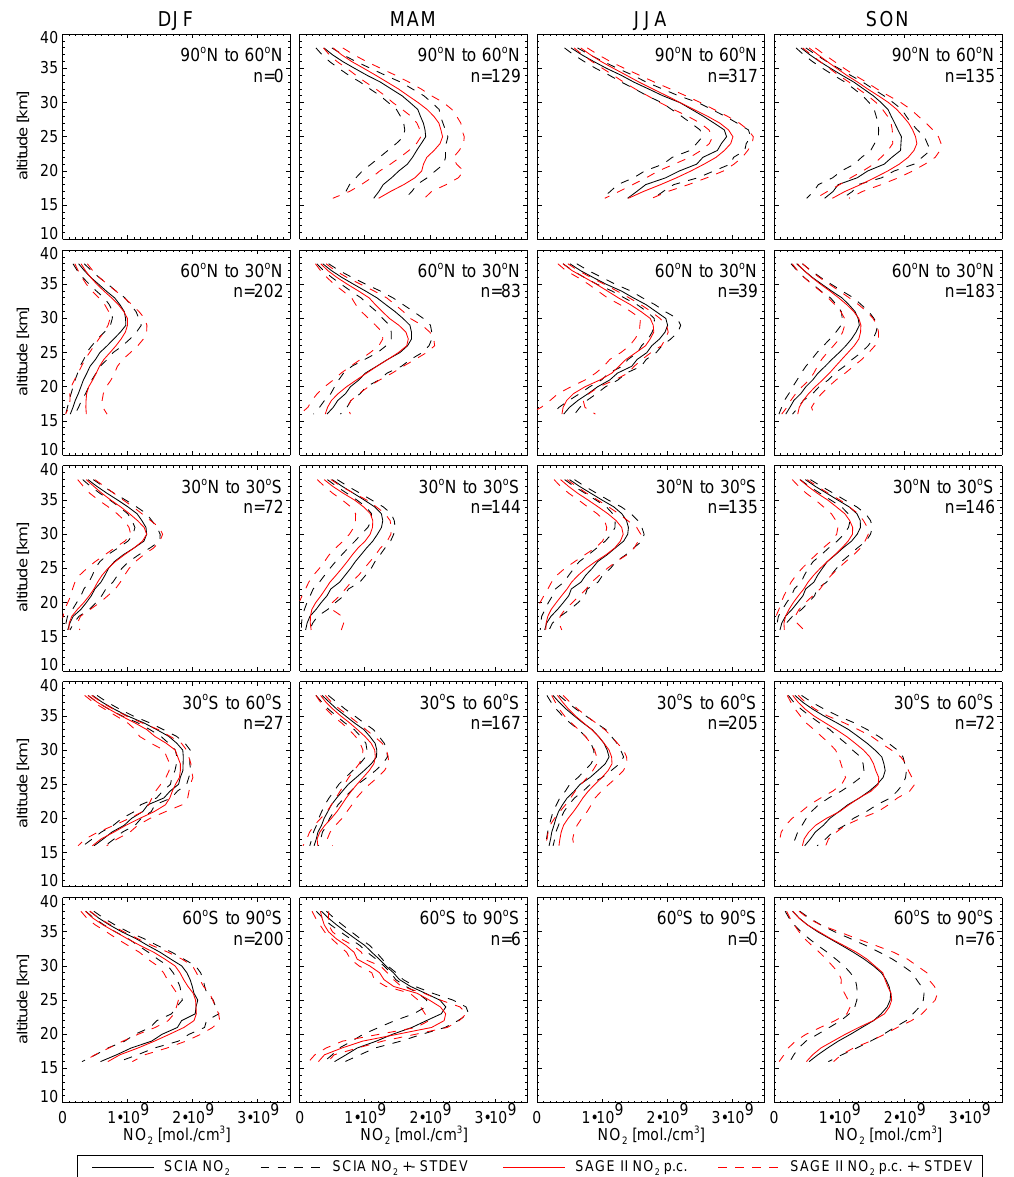
Fig. 9. From the SCIAMACHY and SAGE II collocation pairs for 2003 and 2004, vertical NO 2 profiles are averaged for collocation subsets of different latitude ranges and seasons. The panels are ordered from top to bottom depending on latitude range, with northern latitudes on top. The panels are also ordered from left to right depending on season. In each panel, the NO 2 profiles are averaged for SCIAMACHY (black line) and photochemically corrected SAGE II NO 2 profiles (red). The standard deviations for both subsets are given as dashed lines in the respective color and added/subtracted from the averaged